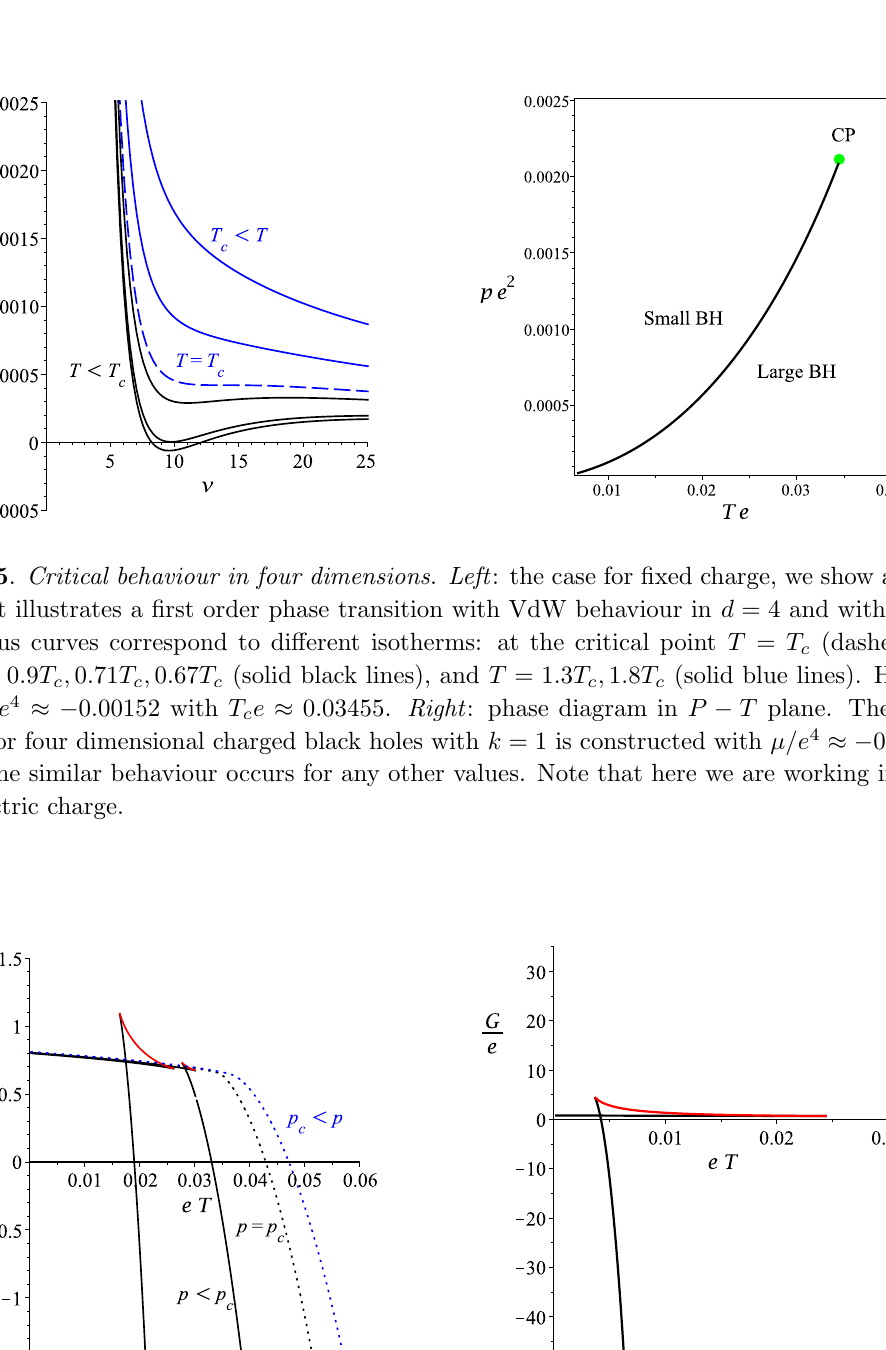
Figure 16 . Free energy in four dimensions . Left : plot of Gibbs free energy versus temperature for d = 4 and k = 1, for P = 1 : 2 P c (dotted, blue curve), for P = P c (dotted, black curve), for P = 0 : 6 P c and P = 0 : 2 P c (solid black and red lines). Right : plot for P = 0 : 01 P c . In each plot, the red lines represent parts of the curves that the speci(cid:12)c heat is negative. In all plots, (cid:22)=e 4 (cid:25) (cid:0) 0 : 00152 where physical conditions are satis(cid:12)ed with P c e 2 (cid:25) 0 : 00211.